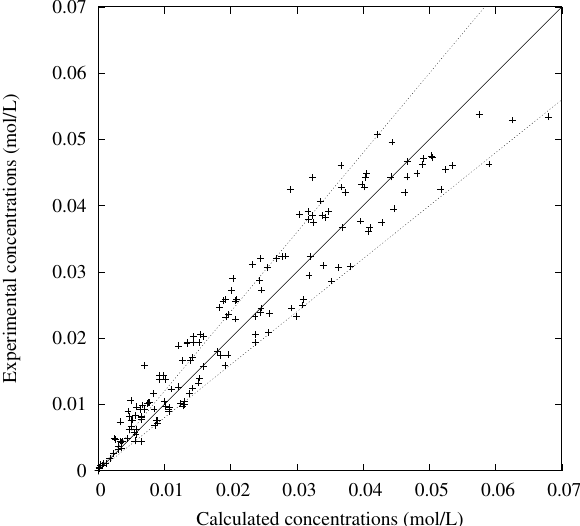
Figure 5. Parity diagram of experimental vs. modeled concentrations of the acetyl-biphenyl product—dashed lines at y = x ±